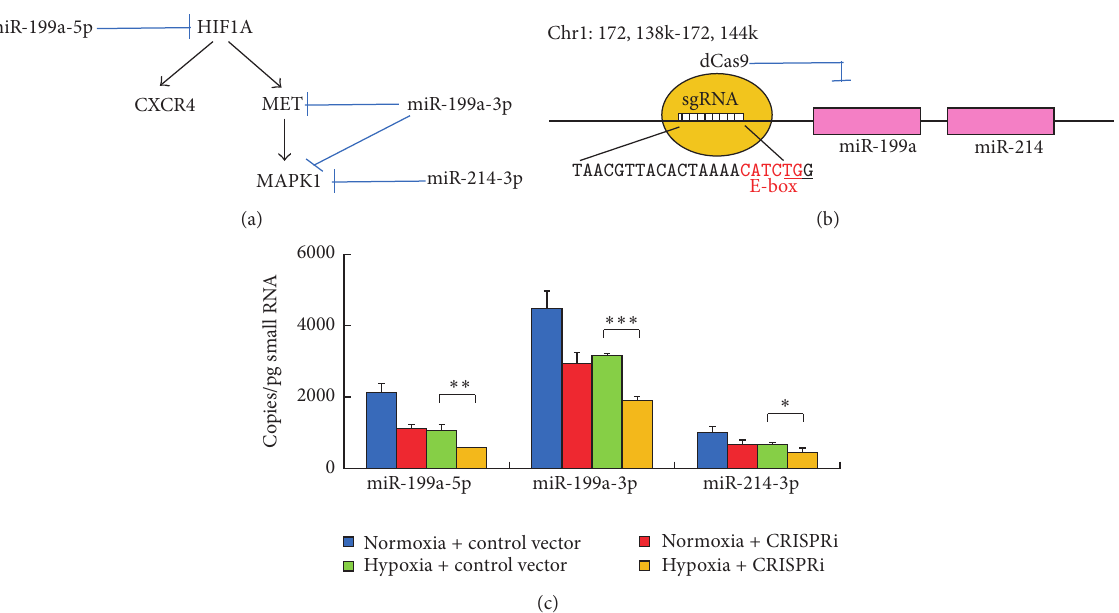
Figure 2: Targeted inhibition of miR-199a/214 cluster using a CRISPRi system in NSCs. (a) Diagram showing miR-199a-5p, miR-199a-3p, and miR-214 of the miR-199a/214 cluster are targeting multiple important components in the signaling pathways that mediate hypoxia-induced migration of NSCs. (b) Schematic representation showing blockage of transcription of the miR-199a/214 cluster using a dCas9 targeting the E-box in the promoter region. The sequence of the gRNA target site is shown and the PAM sequence is underlined. The E-box sequence is highlighted in red. (c) Absolute expression levels of miR-199a-5p, miR-199a-3p, and miR-214 in NSCs are quantified by qPCR ( 𝑛 = 3 ). Error bars: SD. ∗ 𝑃 < 0.05 , ∗∗ 𝑃 < 0.01 , and ∗∗∗ 𝑃 < 0.001